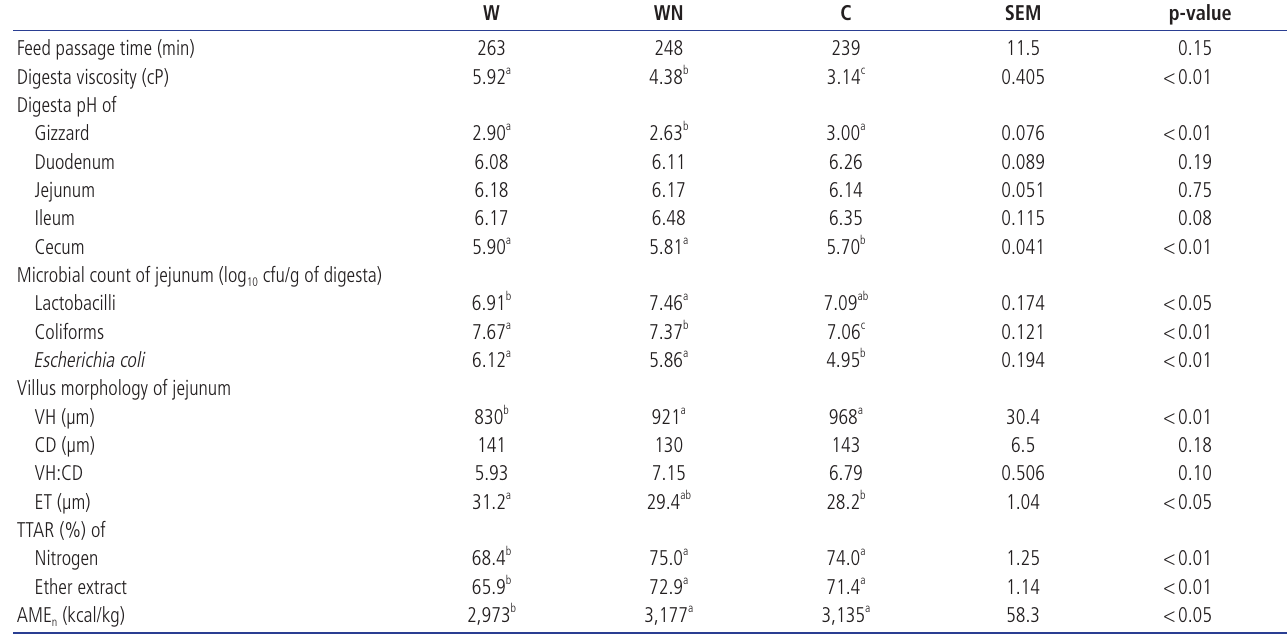
Table 3. Effect of Natuzyme Plus 1) inclusion in wheat-based diet on feed passage time, digesta pH of digestive tract, digesta viscosity, microbial count and villus morphology of jejunum, TTAR of nutrients, AME in broiler n